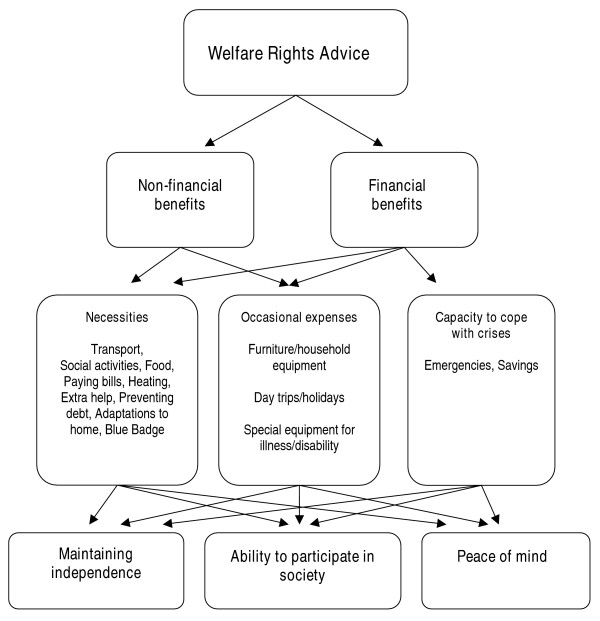
Conceptual model of reported impact of gaining additional financial and non-financial resources.